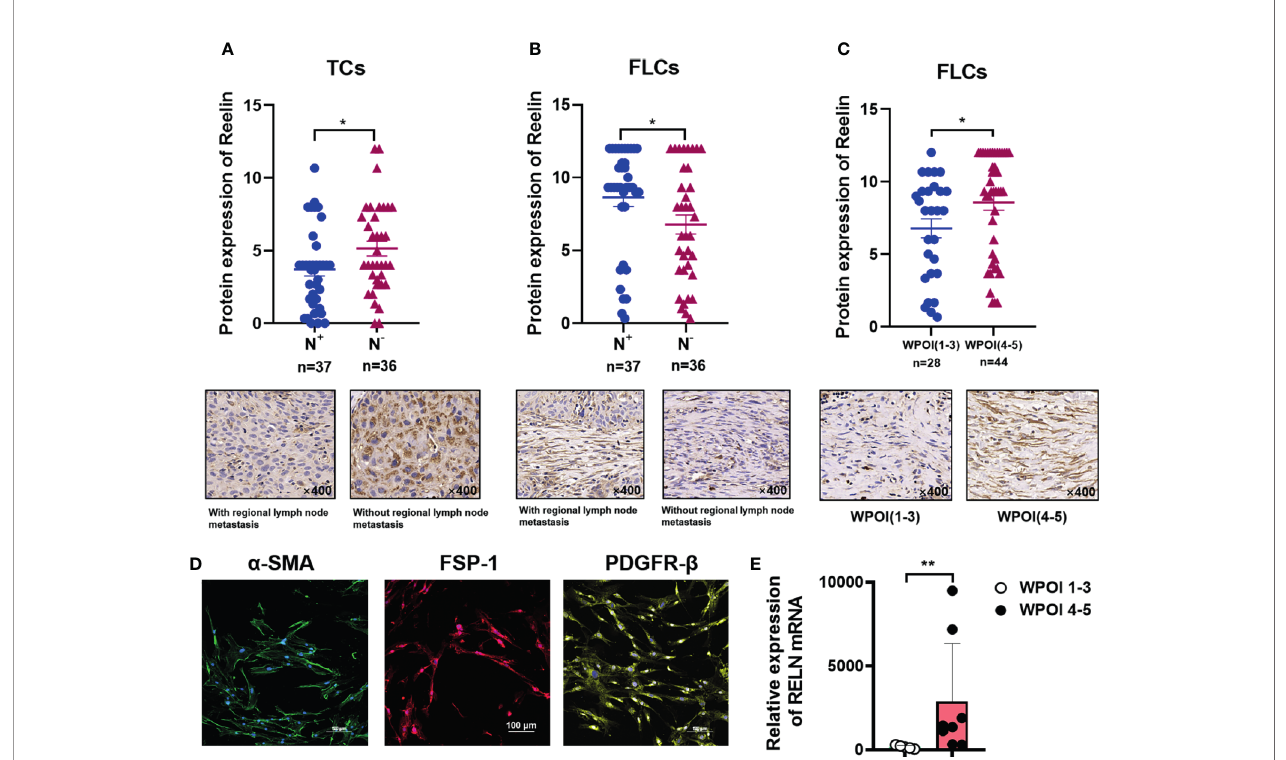
FIGURE 2 | Reelin expression with regional lymph node metastasis in TCs (A) , FLCs (B) , and WPOI in FLCs (C) . Immuno fl uorescence of isolated primary fi broblasts showed that CAFs express a -SMA, FSP-1, and PDGFR- b (D) . Quantitative analysis of RELN mRNA between WPOI (1-3) and WPOI (4-5) revealed signi fi cant difference between two groups (E) . * and ** denote that differences were considered statistically signi fi cant with p < 0.05 and p < 0.01,